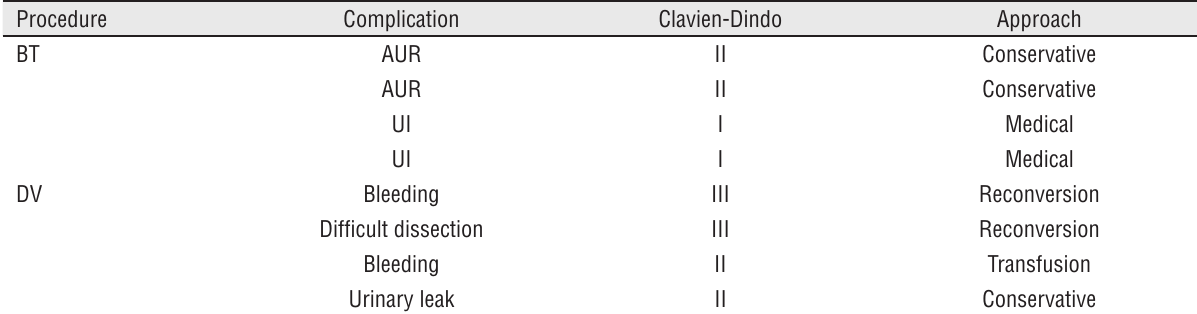
AUR = Acute Urinary Retention; UI = Urinary